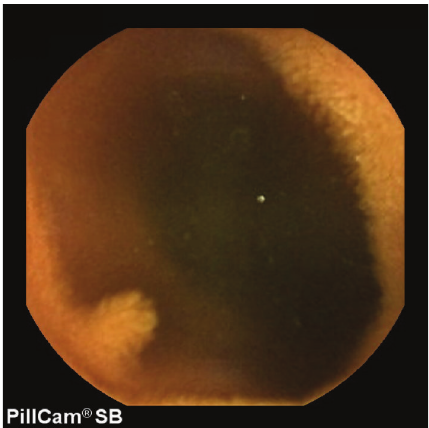
Figure 2: Capsule endoscopy revealed polyps of normal color in the jejunum.